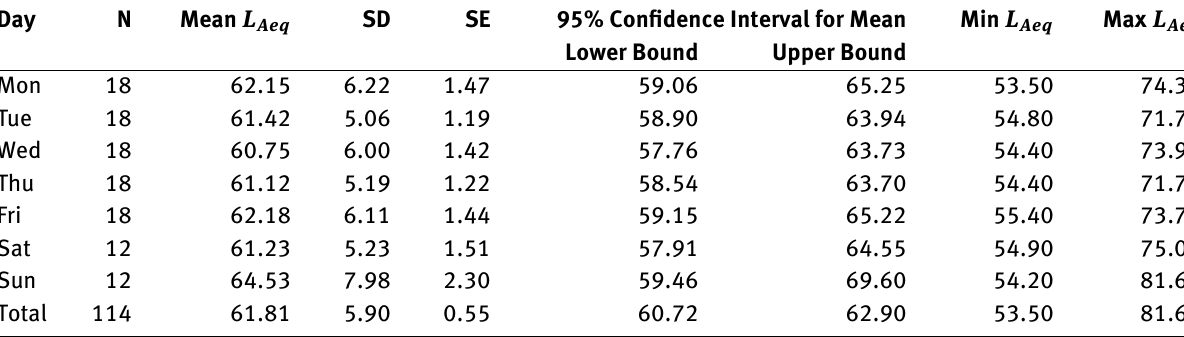
Table 2: Descriptive statistics of L Aeq noise levels –